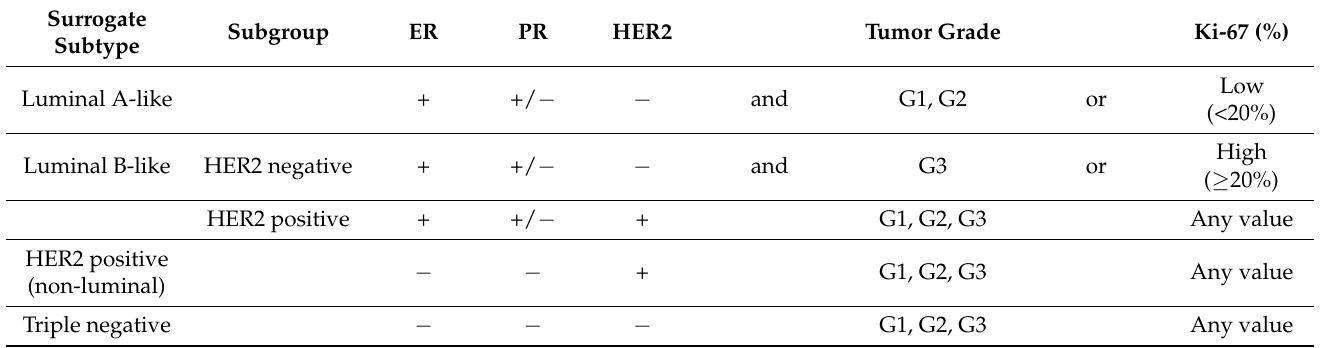
Table 5. Criteria for surrogate IHC+G subtyping according to